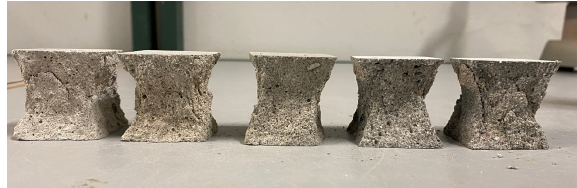
Figure 16. Mortar specimens with UFS, from 0 to 100%.